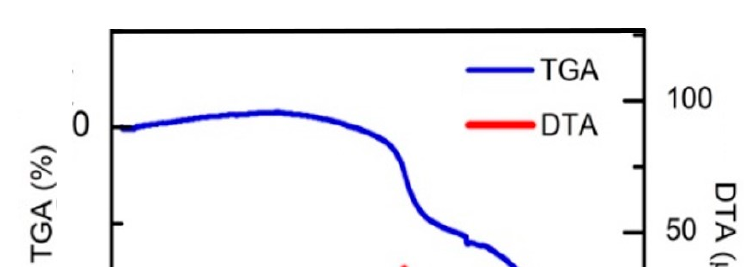
Figure 2. Differential thermal analysis curve of samples using a planetary ball mill after 8h-milled.